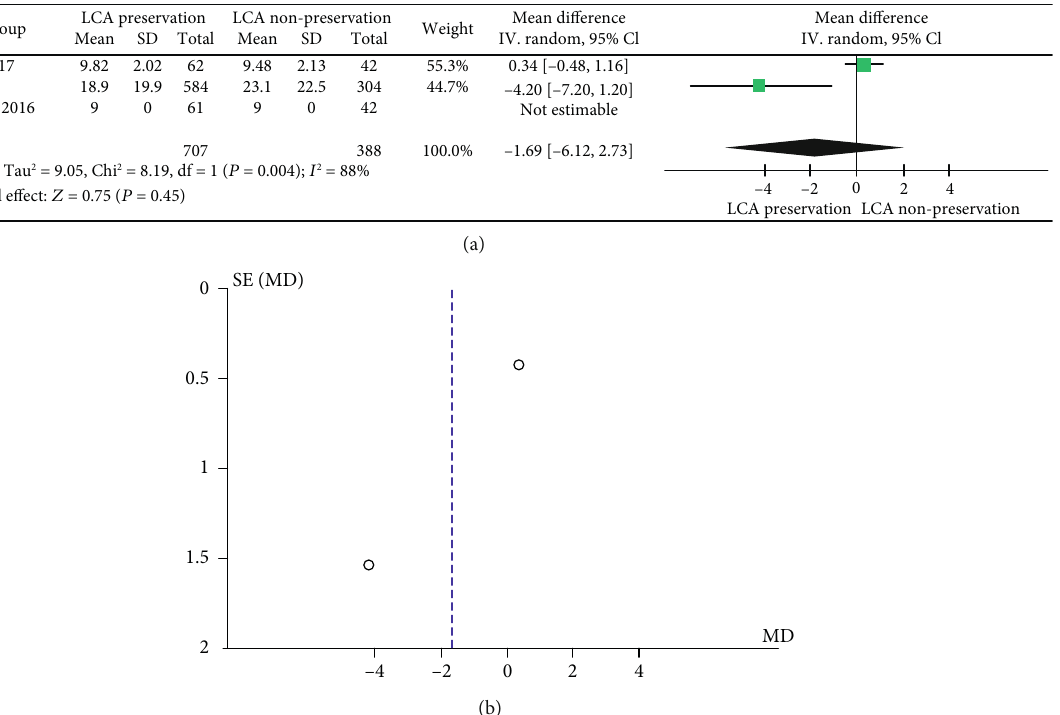
Figure 9: (a) forest plot of postoperative hospital stay; (b) funnel plot of postoperative hospital